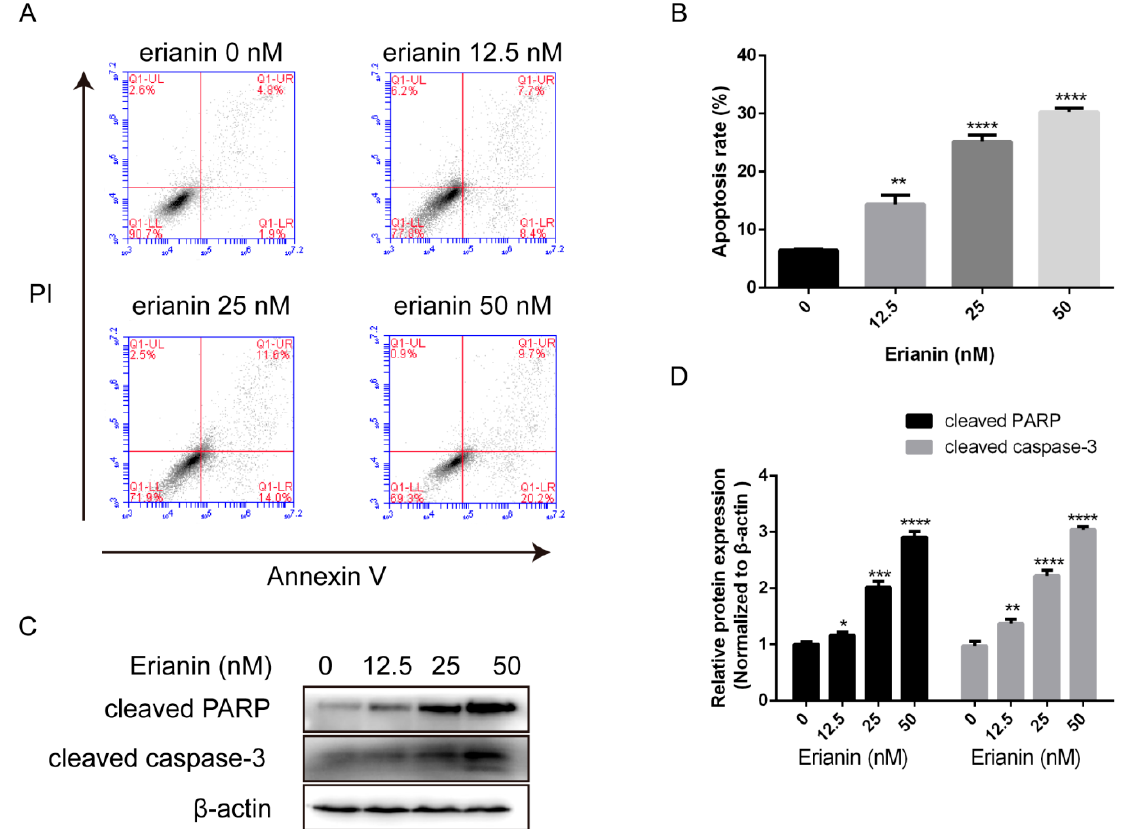
Figure 2. Erianin induced apoptosis in HaCaT cells. Cells were treated with various concentrations of